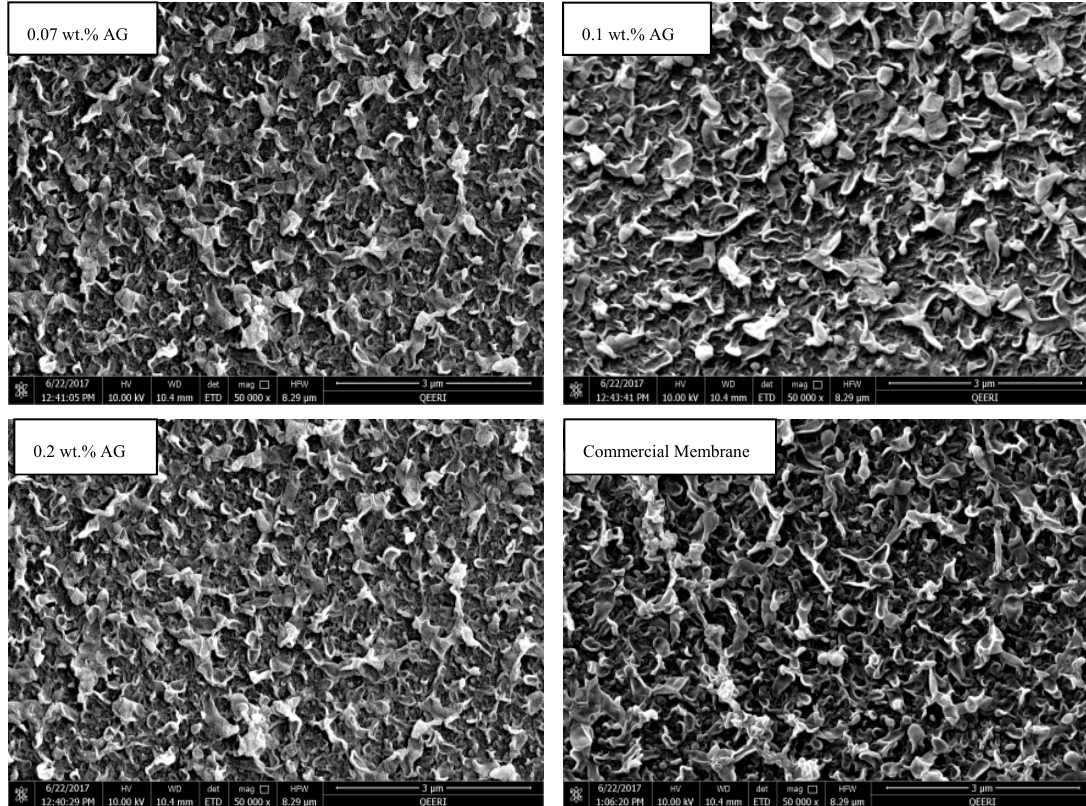
Figure 3. SEM top view of PA membranes with 0.07, 0.1 and 0.2 wt.% AG in dope solution in addition to the commercial AD Osmonic membrane.